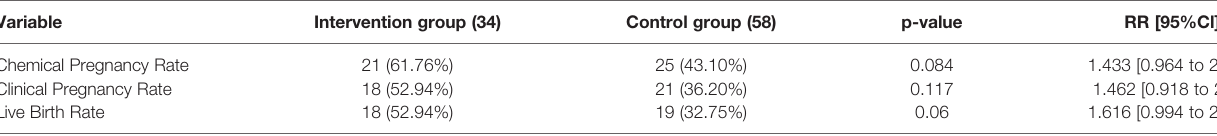
TABLE 5 | Frozen Embryo Transfer Results.